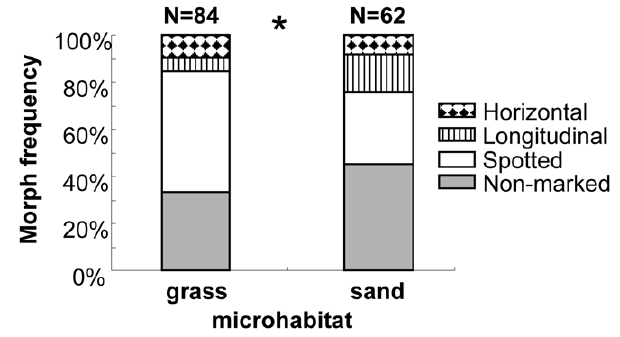
Figure 3. Morph frequency at the study sites (grass and sand microhabitats).